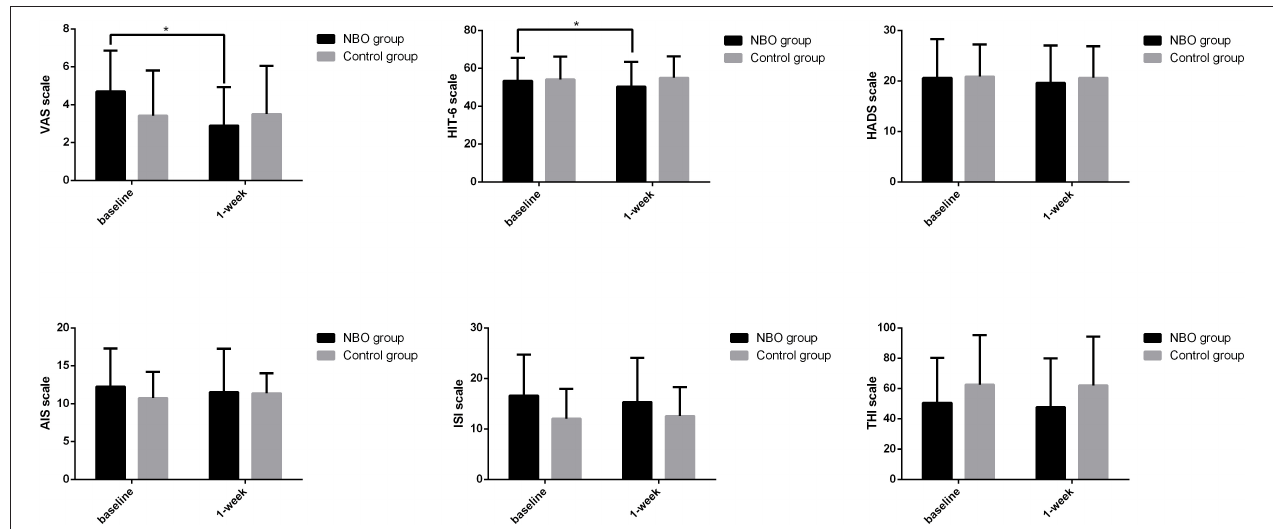
FIGURE 2 | The symptom scales in normobaric oxygen (NBO) and control groups. Visual analog scale (VAS) and Headache Impact Test-6 (HIT-6) scale declined after 1-week NBO performance but remained unchanged after routine medical management. Compared with baseline, 1-week hospital anxiety and depression scale (HADS), Athens insomnia scale (AIS), insomnia severity index (ISI), and tinnitus handicap inventory (THI) improved in the NBO group; however, this change did not reach a statistical significance. * p < 0.05.